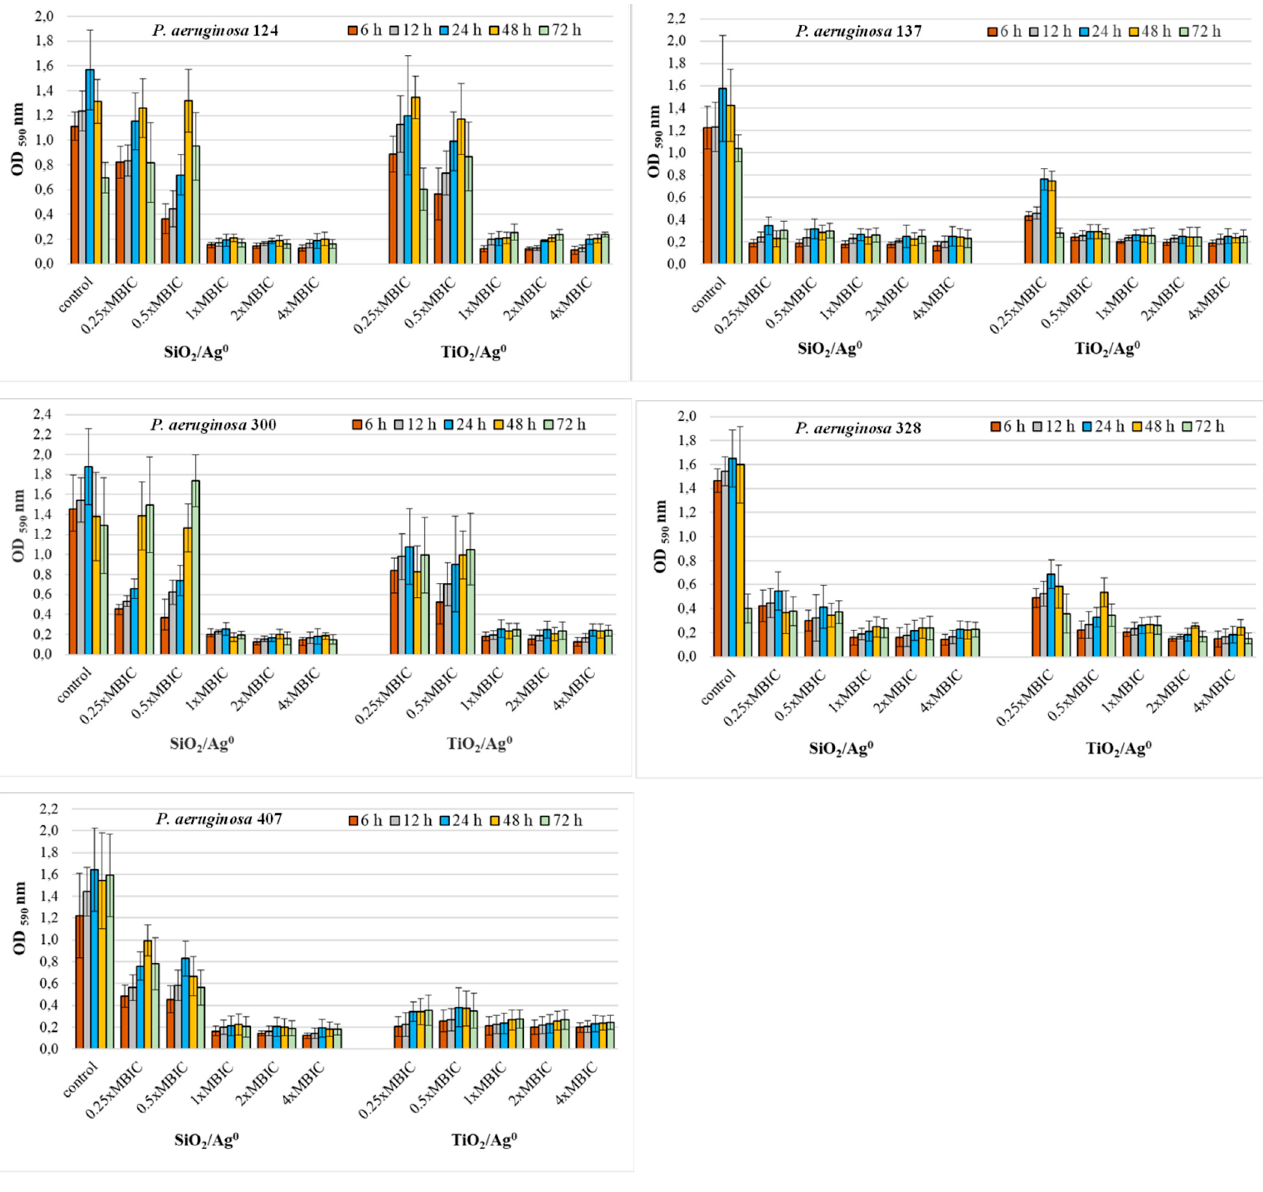
Figure 4. Effect of SiO 2 /Ag 0 and TiO 2 /Ag 0 on biofilm formation by P. aeruginosa strains isolated from urine. Interpretation of the results: OD ≤ 0.096—non-biofilm producer; 0.096 < OD ≤ 0.192—weak-biofilm producer; 0.192 < OD ≤ 0.384—moderate-biofilm producer; OD > 0.384—strong-biofilm pro- ducer.